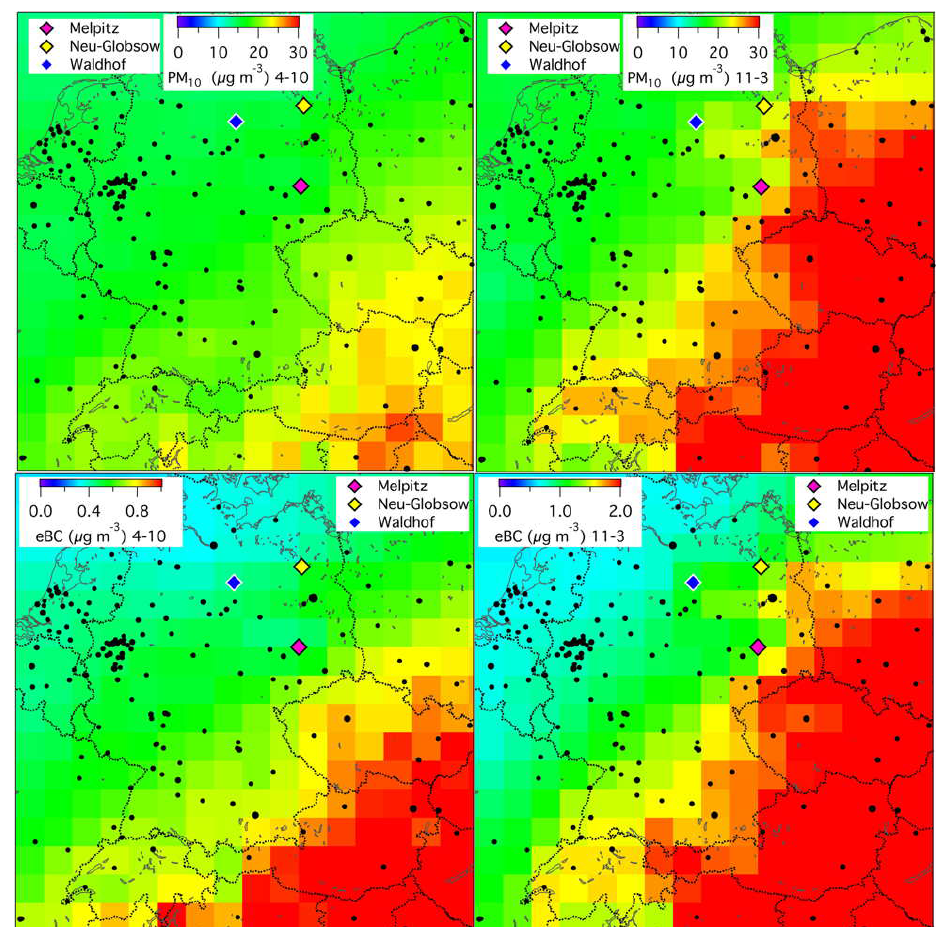
Figure 2. As Fig. 1 but for particle mass concentrations (top, PM 10 ; µgm − 3 ) and black carbon concentrations (bottom, eBC; µgm − 3